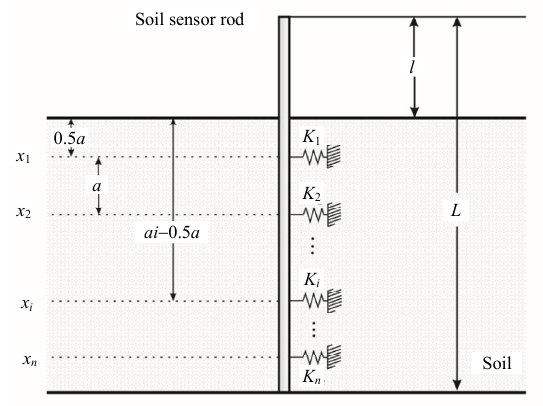
Fig. 5 Winkler spring model.